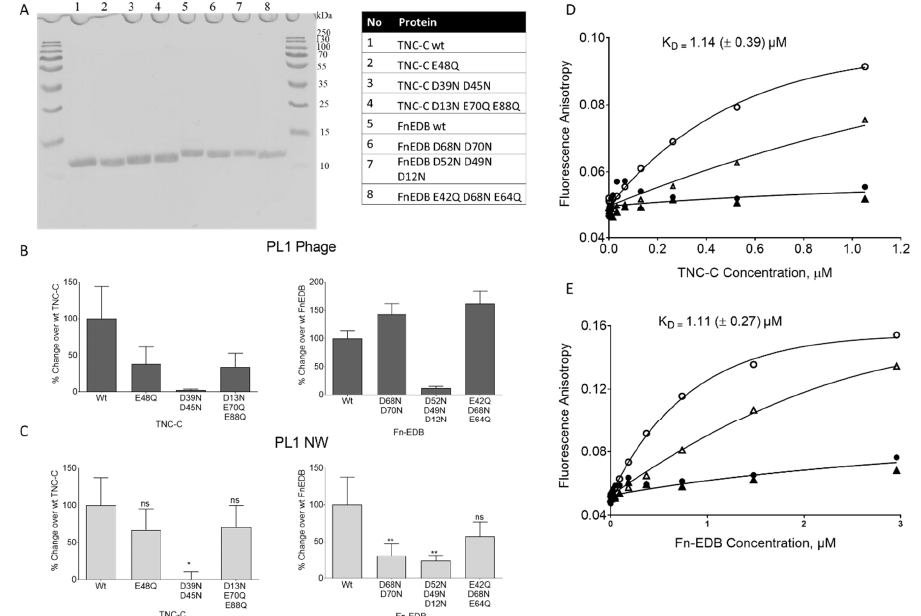
Figure 3. WT and mutant FN-EDB and TNC-C: binding of PL1 peptide NPs and free peptide. ( A ) The WT and mutant FN-EDB and TNC-C isoforms were expressed in E. coli. Coomassie blue-stained SDS PAGE of His-tagged recombinant proteins (loading scheme listed in the table) after purification on HisTrap HP columns; ( B ) binding of the PL1 peptide phage to immobilized TNC-C and FN-EDB isoforms. The phage binding is expressed as percent binding over parental WT FN-EDB and TNC-C; ( C ) binding of FAM-labeled PL1-NWs to NiNTA beads immobilized recombinant TNC-C and FN-EDB proteins. The mutant TNC-C (D39N, D45N) and FN-EDB (D52N, D49N, D12N) showed a ~100% and ~76% reduction in binding over WT protein. The PL1-NW binding is expressed as percent binding over parental WT FN-EDB and TNC-C proteins after baseline correction with control protein P32. The binding data are representative of three independent experiments. Error bars: mean ± standard error of the mean (SEM), ns p > 0.05, * p ≤ 0.05, ** p ≤ 0.01. ( D , E ) Binding curve characterizing PL1 peptide binding to TNC-C and FN-EDB. FAM-PL1 [0.468 µ M (circles) and 4.68 µ M (triangles)] was incubated with different concentrations of TNC-C ( D ) and FN-EDB ( E ) in the absence (total binding, open symbols) or presence (non-specific binding, filled symbols) of 0.5 mM biotin-PL1. After incubating 24 h at 25 ◦ C, FA values were measured, and binding parameters were calculated as described in Materials and Methods. Data are representative of three independent